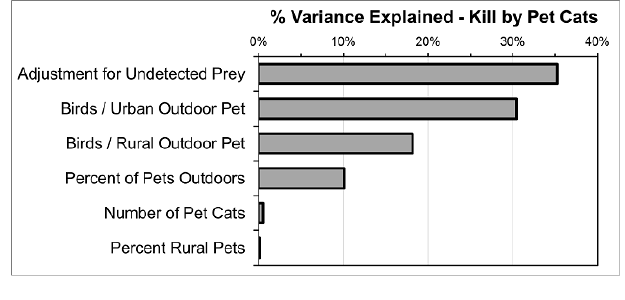
After excluding feral cat parameters, estimates of birds killed by pet cats were about equally sensitive to variance in the adjustment factor used to convert birds returned home to birds killed, and the rate at which birds were returned by outdoor urban pets (Figure